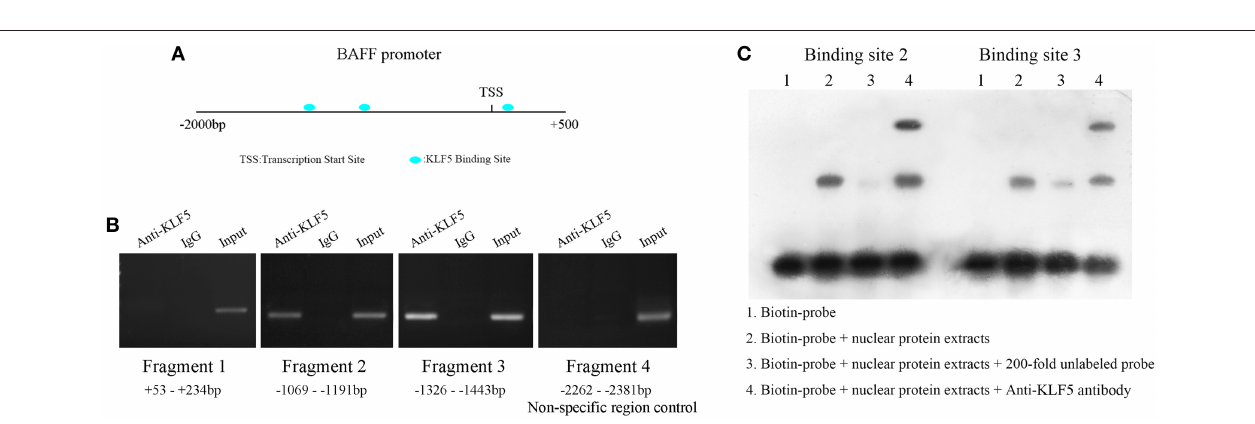
FIGURE 5 | KLF5 is bound to BAFF promoter. (A) Prediction of transcription factor binding sites in BAFF promoter region. (B) ChIP-PCR showed that KLF5 bound to the promoter of BAFF in B-cells. (C) EMSA was used to detect the binding of KLF5 with binding sites 2 and 3 in BAFF promoter region in vitro . The biotin probe specific for sites 2 or 3 was bound by nuclear protein extracts of B-cells of healthy controls, which could be blocked by a KLF5